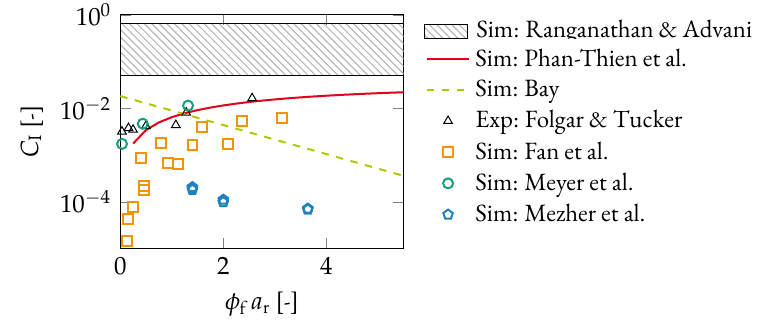
Figure 2. Comparison of C I as published by various